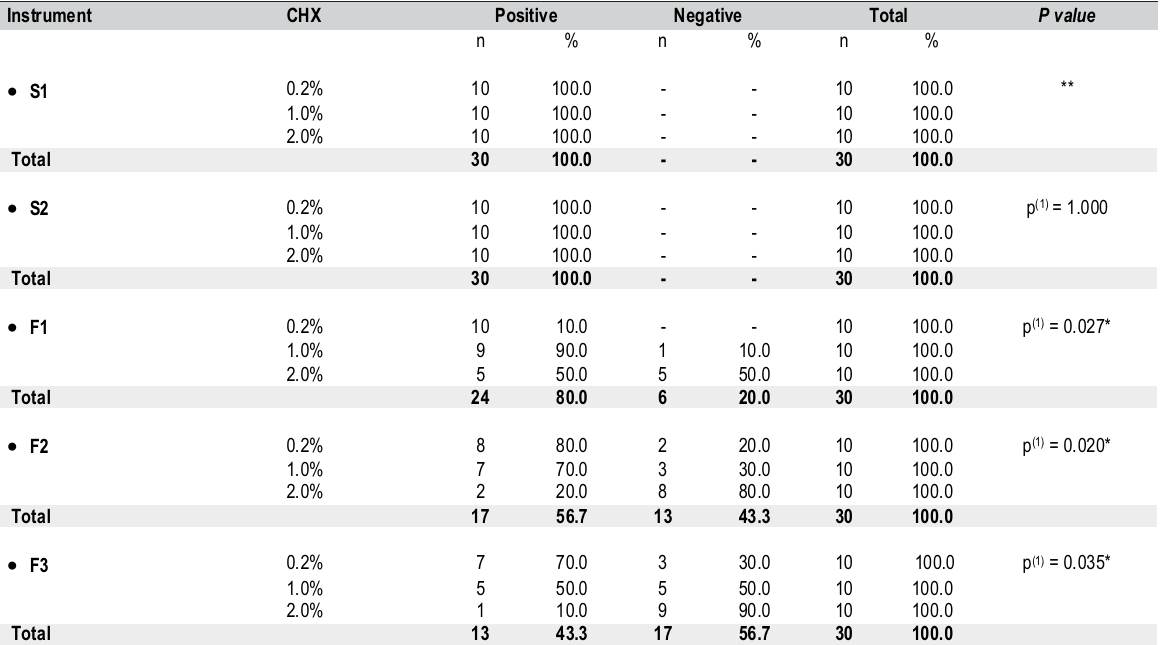
Table 4. Antimicrobial efficacy of 0.2%, 1%, and 2% CHX in root canals infected by E. Instrument CHX Positive Negative